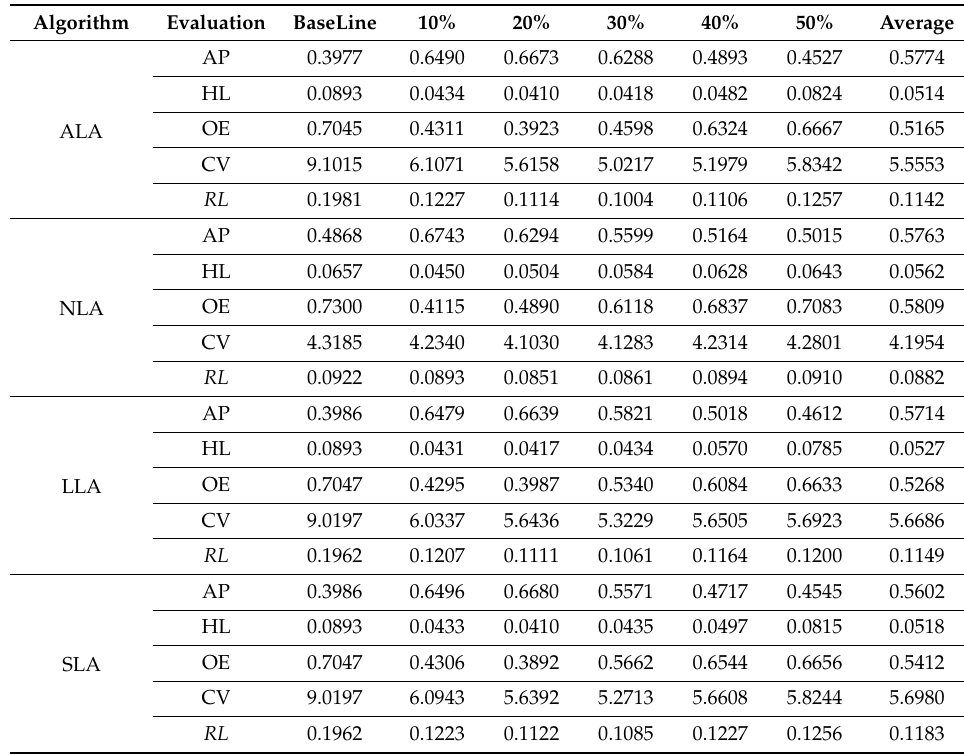
Table 7. Experimental results on Health data set.